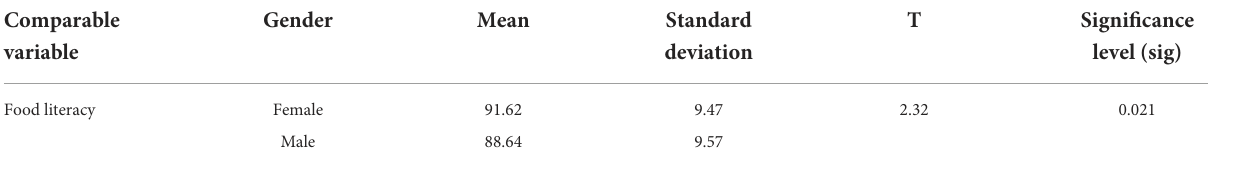
TABLE 4 Mean comparison tests of food literacy between the five educational groups and monthly income. Comparable variable